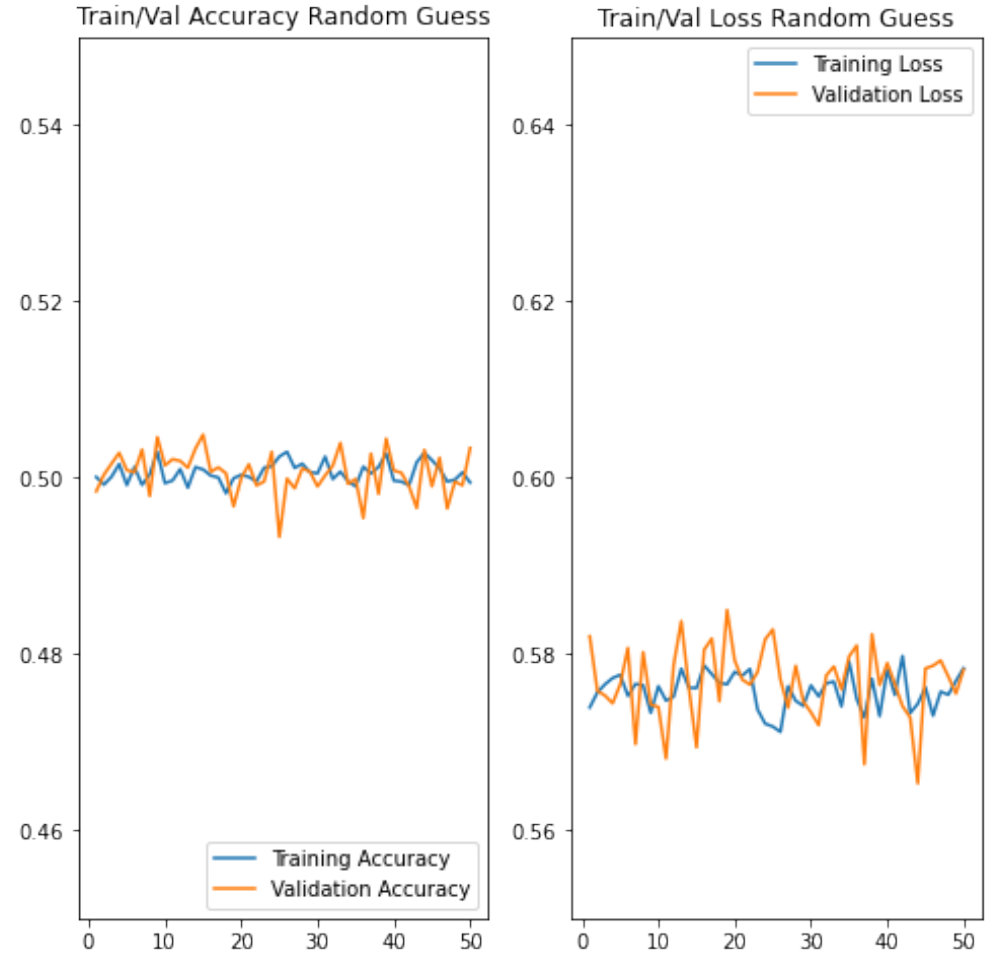
Figure 5. Training/validation loss and accuracy for the Baseline classifier (Random